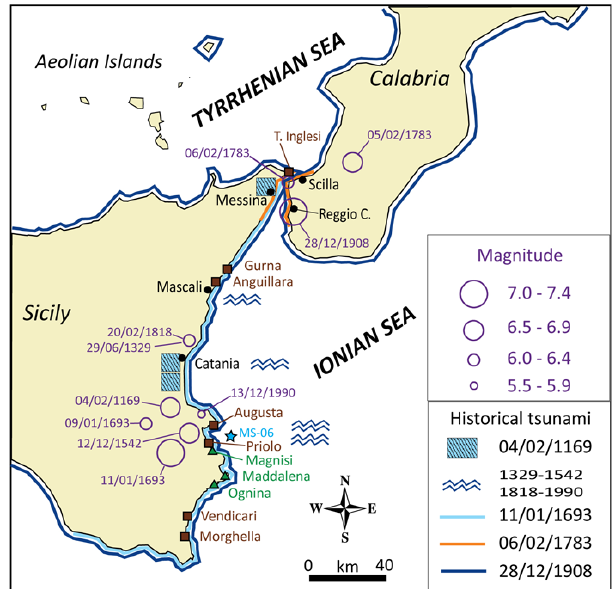
Fig. 2. Map of eastern Sicily showing the main tsunamigenic earth- quakes which occurred in historical time and inundated areas by the most energetic regional tsunamis (modified from Gerardi et al., 2012). Mascali, Catania and Augusta were also affected by the 1329, 1818, 1542 and 1990 local tsunamis (wavy symbol), respec- tively (see Table 1). Scilla and Torre Faro are related to the 1783 tsunami probably triggered by a submarine landslide (e.g., Gerardi et al., 2008; Bozzano et al., 2011). Investigated sites are shown with brown squares and with green triangles when studied by our group or by other researchers, respectively. The light blue star shows the location of the long sediment gravity core